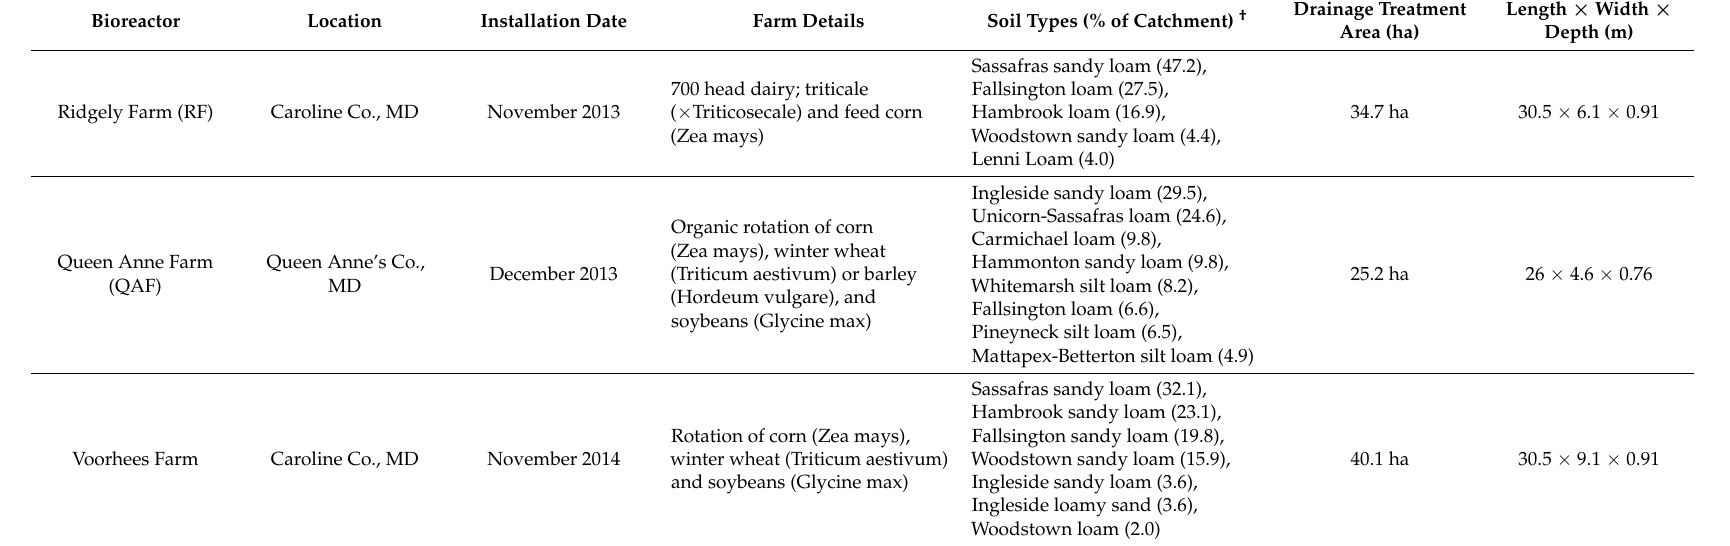
Table 1. Description of three agricultural drainage denitrifying bioreactors in Maryland studied in this